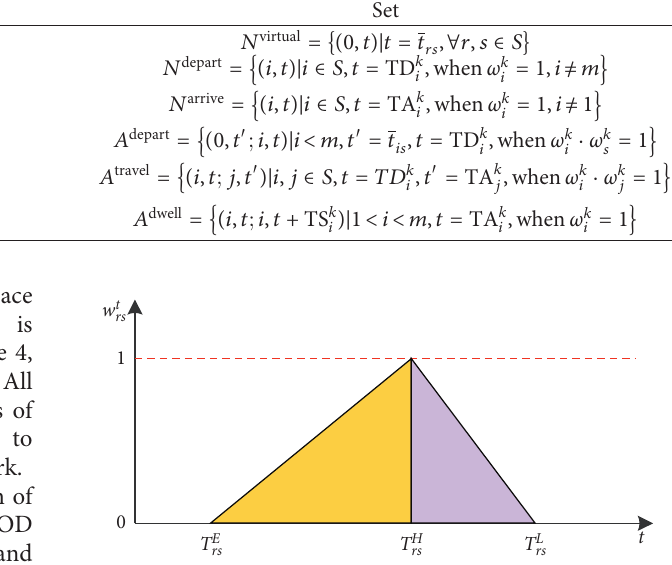
Figure 5: Triangular fuzzy number distribution of departure time